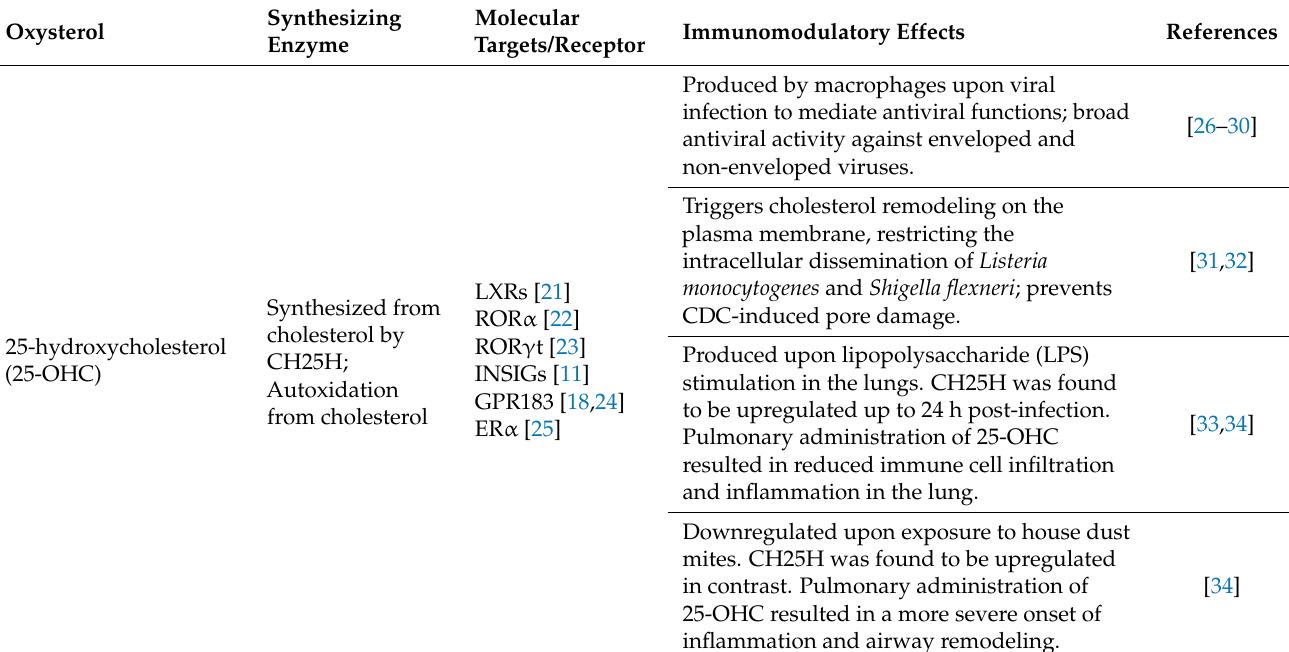
Table 1. Selected oxysterols and their receptors. Oxysterols are known to bind to the receptors listed in this table; however, in some cases it remains to be confirmed through which receptor the immune modulatory effects are